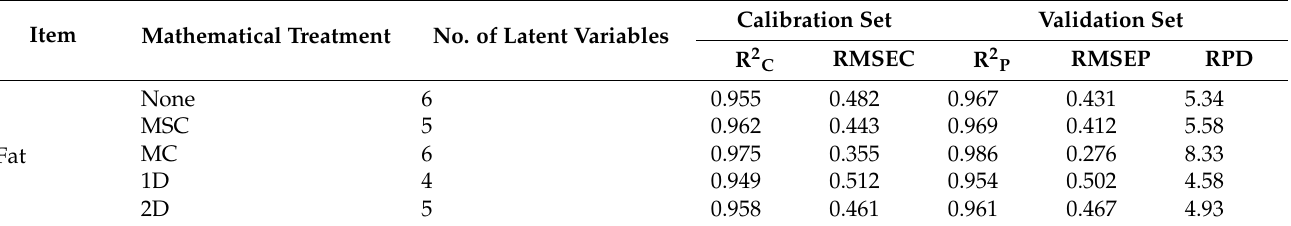
Table 5. Statistics of the PLS model prediction of the fat content in living Tenebrio molitor larvae.